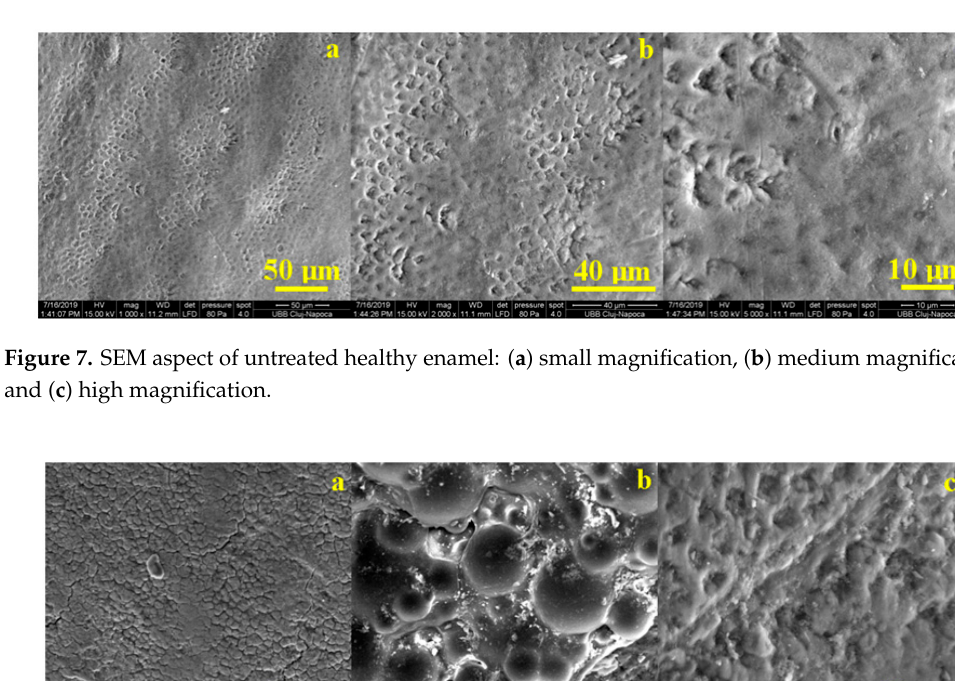
Figure 7. SEM aspect of untreated healthy enamel: ( a ) small magnification, ( b ) medium magnification, and ( c ) high magnification. Figure 6. Appearance of Candida albicans culture plates 48 h after inoculation of experimental extract: inhibition diameters when inoculating 35 µ l of 35%, 40% and 50% extract ( a ) and inhibition diameters when inoculating 50 µ l of 35%, 40% and 50% extract, as well as 100 µ l extract 50% ( b ). Coatings 2020 , 10 , x FOR PEER REVIEW